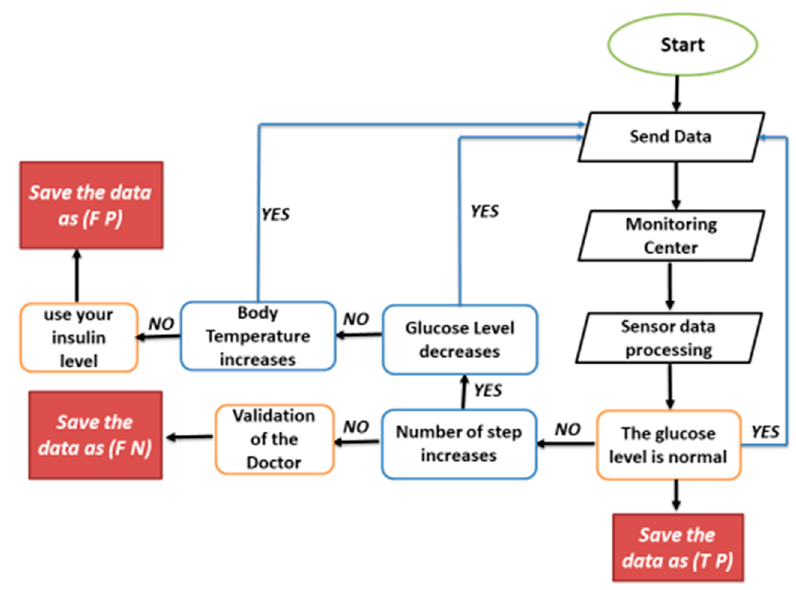
Figure 5. Smart algorithm for monitoring diabetic patients.